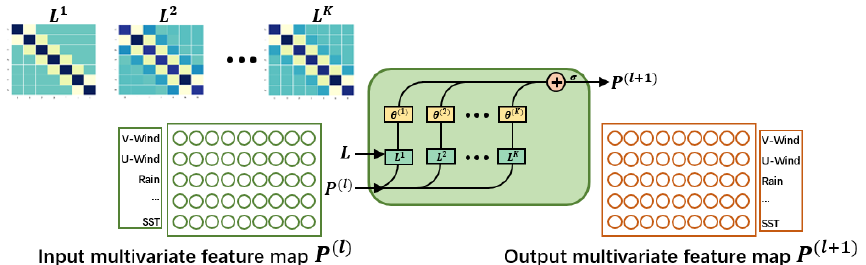
Figure 7. K -order graph convolution layer. K is the truncated order and L K represents the interactions between K -order neighbors. Each row in p (l) and p (l + 1 ) represents features of different physical variables, and their positions are not changed during forward propagation.